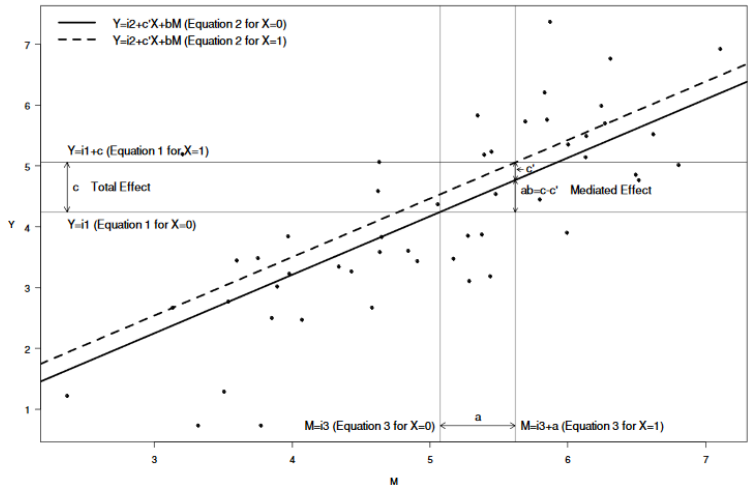
Figure 5. Mediation effect (for simplicity, hats are not included in the coefficient estimates).